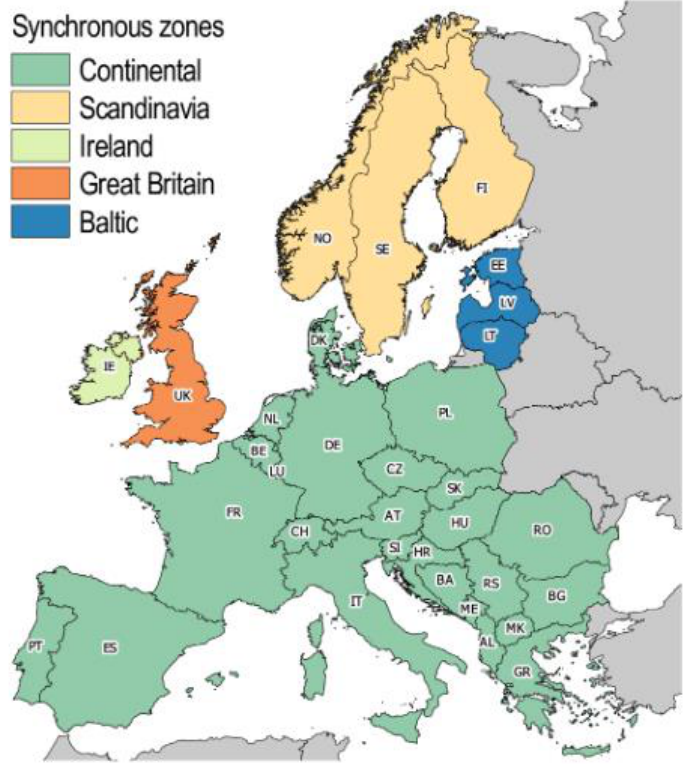
Figure 1. Dynamic electricity model (dynELMOD) geographical coverage (Gerbaulet and Lorenz, 2017).